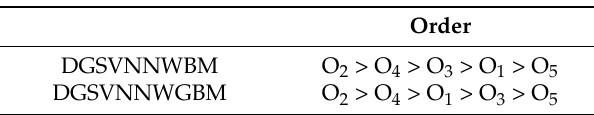
Table 3. Order of the strategic suppliers.